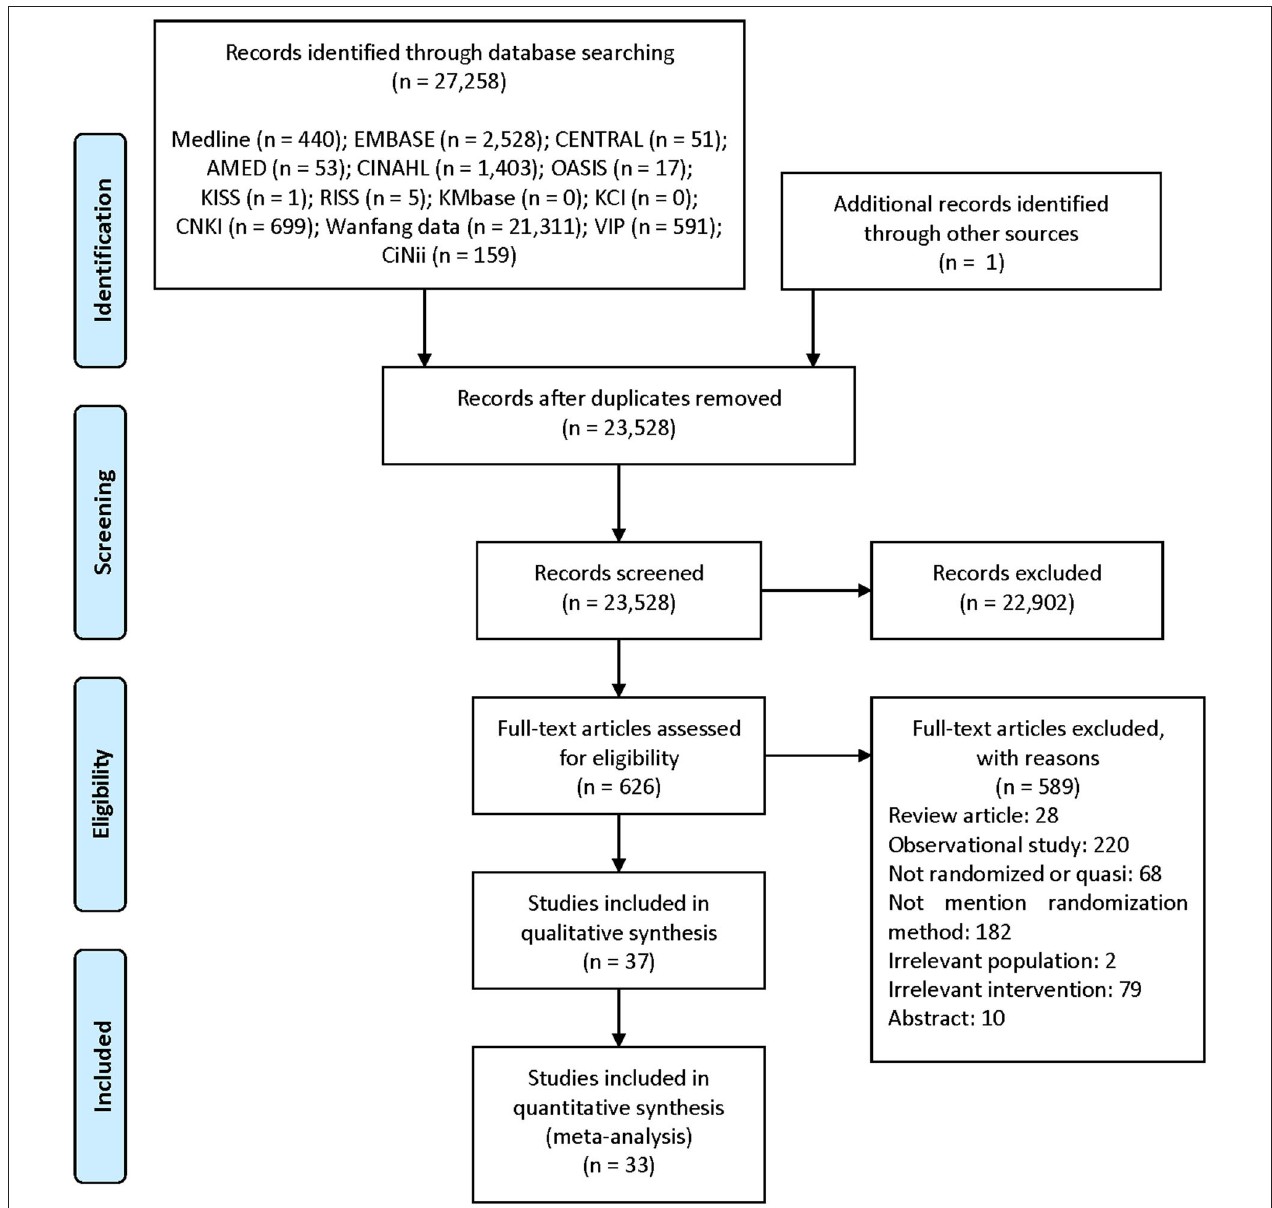
FIGURE 1 | PRISMA flow diagram of the literature screening and selection processes Moher et al. (83). AMED, Allied and Complementary Medicine Database; CENTRAL, Cochrane Central Register of Controlled Trials; CINAHL, Cumulative Index to Nursing and Allied Health Literature; CNKI, China National Knowledge Infrastructure; KCI, Korea Citation Index; KISS, Koreanstudies Information Service System; KMbase, Korean Medical Database; OASIS, Oriental Medicine Advanced Searching Integrated System; RISS, Research Information Service